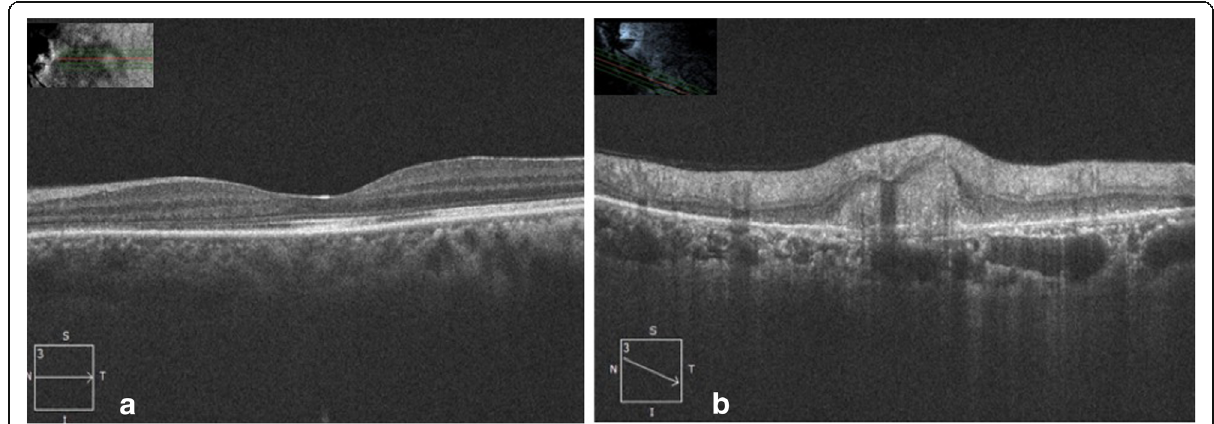
Fig. 7 a OCT of the left eye through the macula showing resolved subretinal fluid. b OCT of the left eye through the retinochoroiditis lesion showing decreased retinal thickening with resolved PED and subretinal